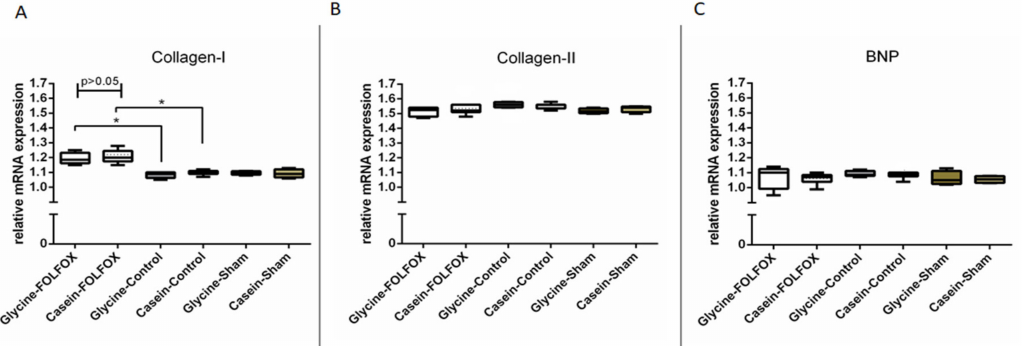
Figure 8. Type I and II collagen and brain natriuretic peptide (BNP) gene expression in the heart muscle by qPCR. Type I collagen gene expression was significantly increased in FOLFOX groups (Casein–FOLFOX; Glycine–FOLFOX) compared to that in corresponding controls (Casein–Control; Glycine–Control), * p < 0.05. Although, there was no di ff erence between Casein–FOLFOX and Glycine–FOLFOX groups ( A ). Type II collagen ( B ) and BNP ( C ) expression was not di ff erent between the study